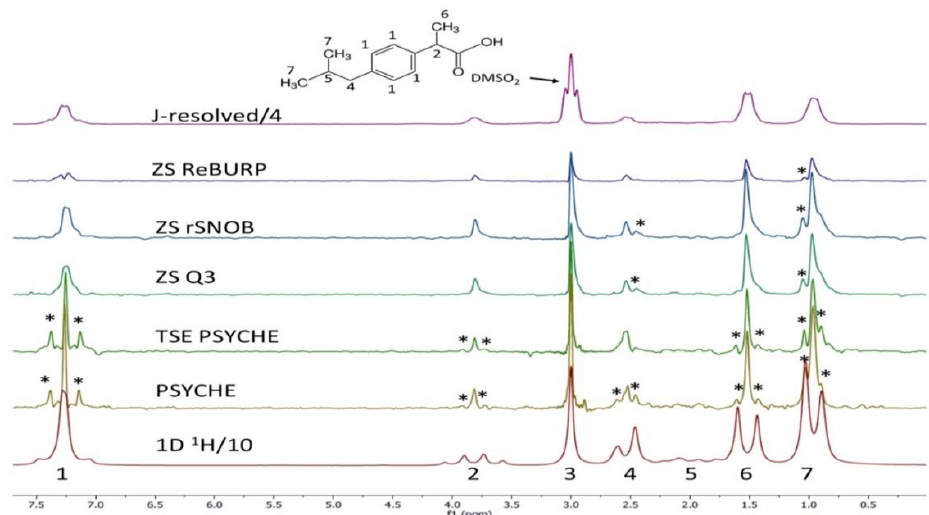
Figure 11. 1 H NMR spectra (43 MHz) of ibuprofen recorded using several pulse sequences for spectral resolution and sensitivity enhancement. The asterisk (*) denotes decoupling artifacts due to partially collapsed strong couplings. Adapted with permission from [108], Wiley, 2019.